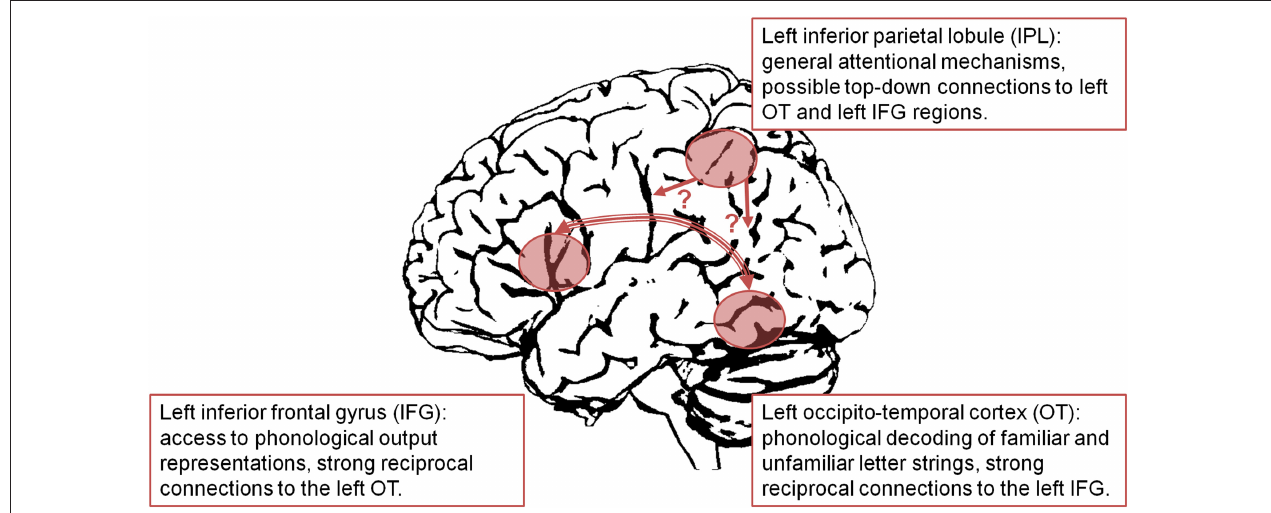
FIGURE 1 | Dysfunction of a left hemisphere reading network in developmental